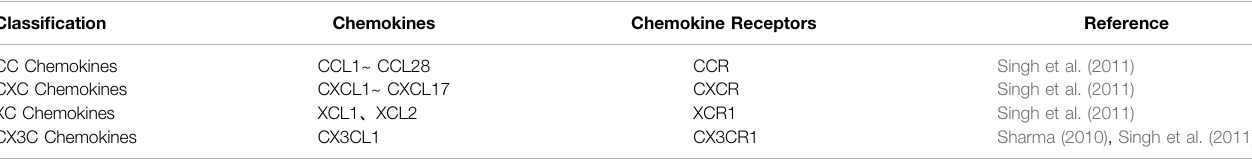
TABLE 1 | Classi fi cation of